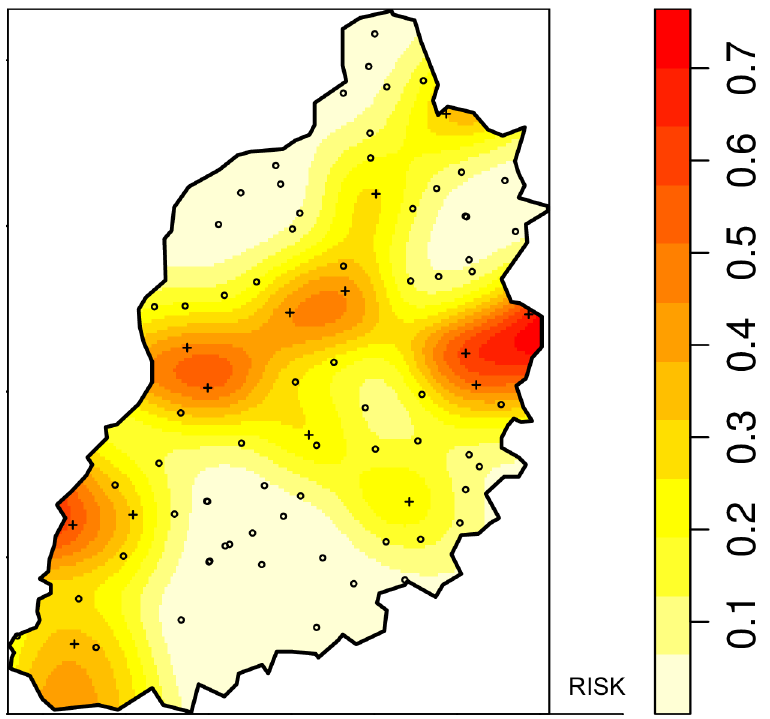
Fig 4. Spatially-smoothed risk map for RVFV seropositivity in slaughterhouse workers. The points are the locationsof the individualslaughterhouses.